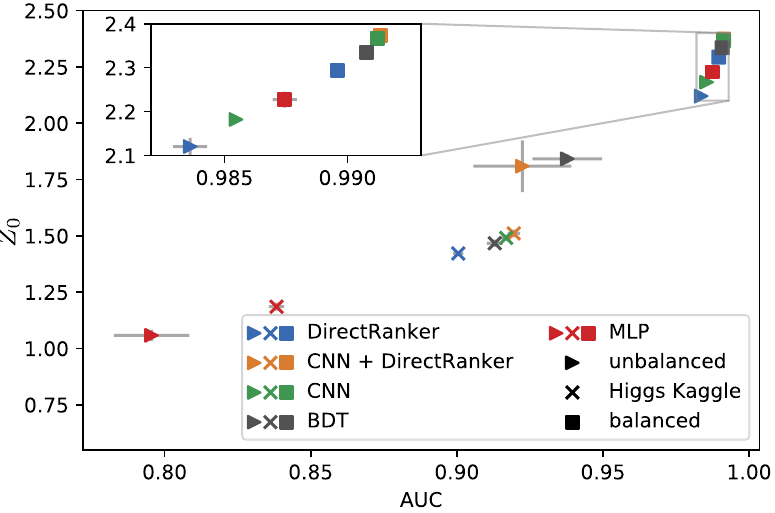
Figure 2. Results of the grid search on t ¯ t background and Higgs signal data. The performance of the models is measured by Z 0 and AUC. The models are trained and tested on different data sets. The models marked with ⊲ are trained on unbalanced and tested on balanced data. The ones shown with × are trained and tested on the Kaggle Higgs boson challenge 33 . The ones plotted with (cid:31) are trained and tested on balanced